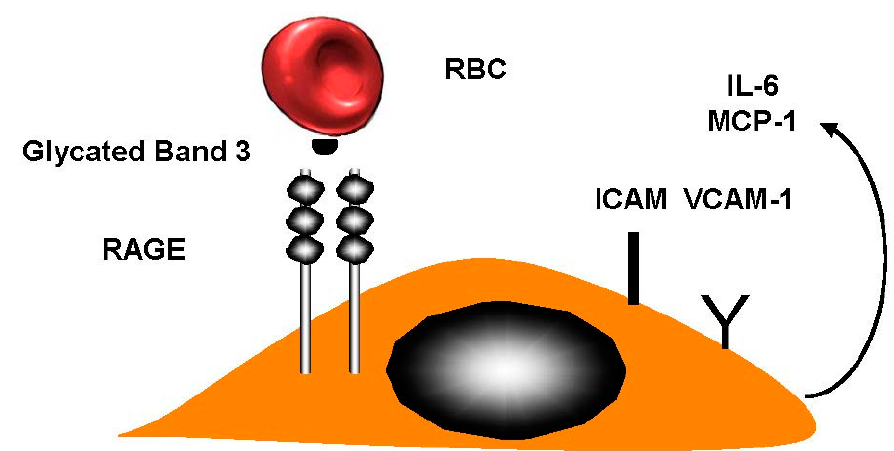
Figure 5. Diabetes mellitus. When people suffer from diabetes the RBC-band-3 protein is also likely to be glycated (AGE). The binding to the endothelial cell receptor for advanced glycation end products (RAGE) activates ECs, inducing tissue factor (TF) production, intercellular cell adhesion molecule-1 (ICAM-1) and vascular cell adhesion molecule (VCAM)-1 expression. The activation induced interleukin-6 (IL-6), vascular endothelial growth factor (VEGF), and macrophage chemoattractant protein-1 (MCP-1) release.